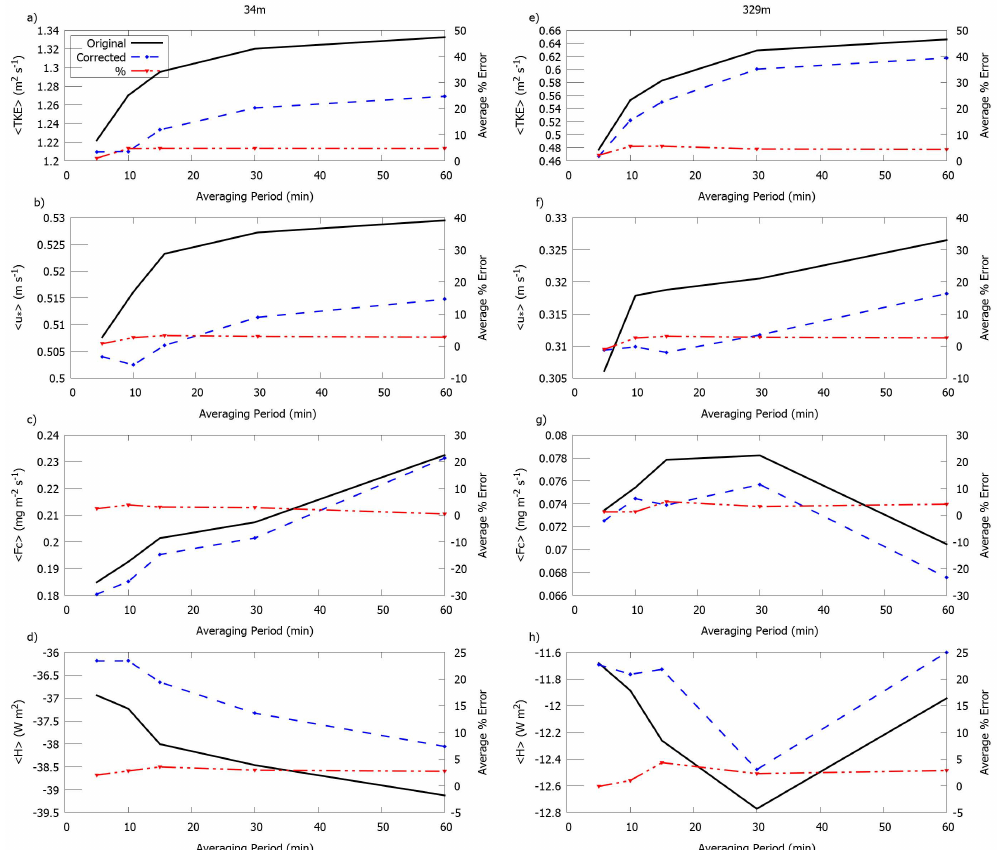
Fig. 6. Average turbulent kinetic energy <TKE> (a, e) , friction velocity < u ∗ > (b, f) , CO 2 flux <F c > (c, g) , and sensible heat flux <H> (d, h) for the “original” (solid) and “corrected” (dashed) time series during the wave event on 3 December 2009 at the 34 and 329m levels on the tall tower are depicted using different averaging periods. The average percent error (dot-dashed) introduced by the absence of such corrections is also